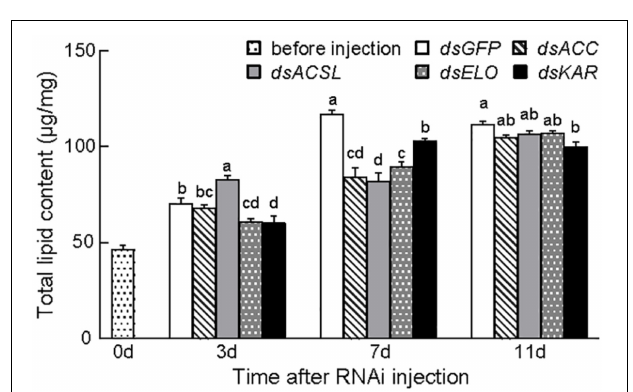
FIGURE 4 | Total lipid levels after dsRNA injection of CsACC, CsACSL , CsELO , and CsKAR . Baseline (before injection) represents the total lipid level content 3 days after eclosion. Data are presented as mean ± SE. Significance analyses were performed using Tukey’s post-hoc test. Different letters indicate a significant difference between stages ( P <